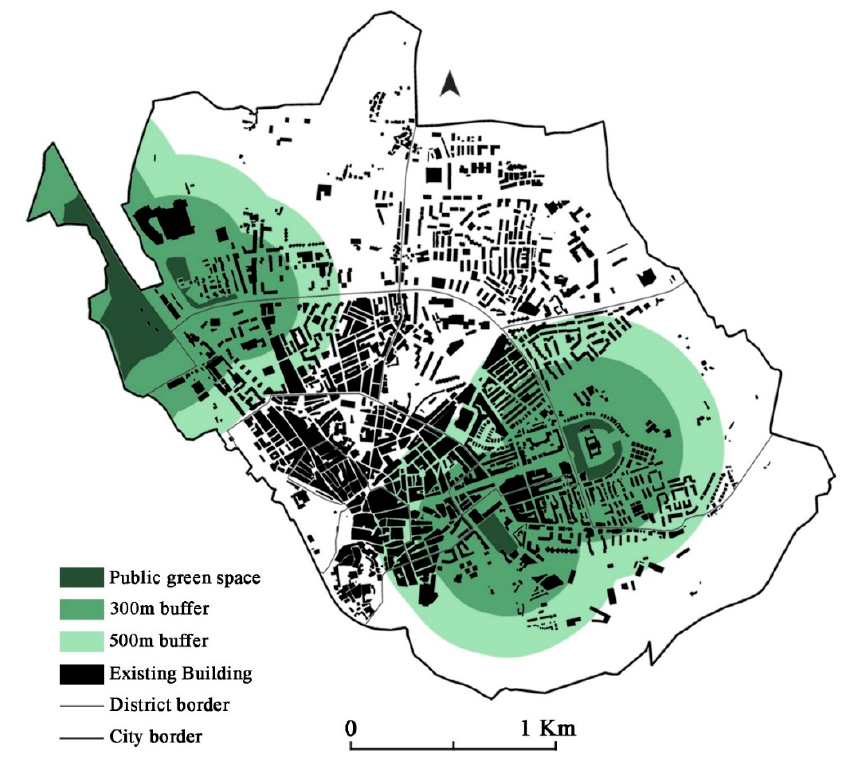
Figure 5. Accessibility of pubic green spaces (PGS) in Faro, using the “walkability” distance method (300 and 500 m buffer).